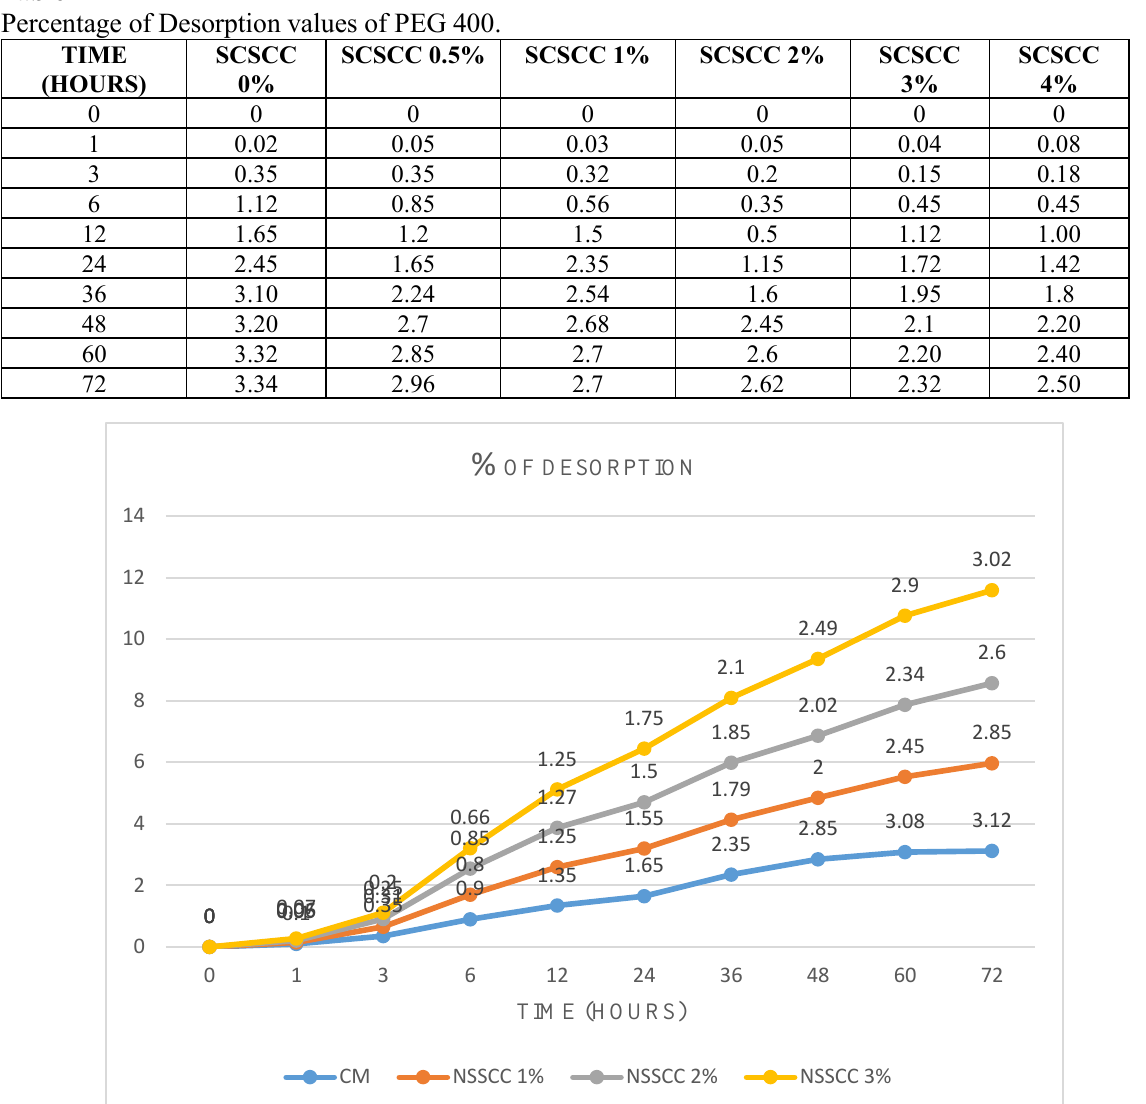
Percentage of Desorption values of PEG 400.